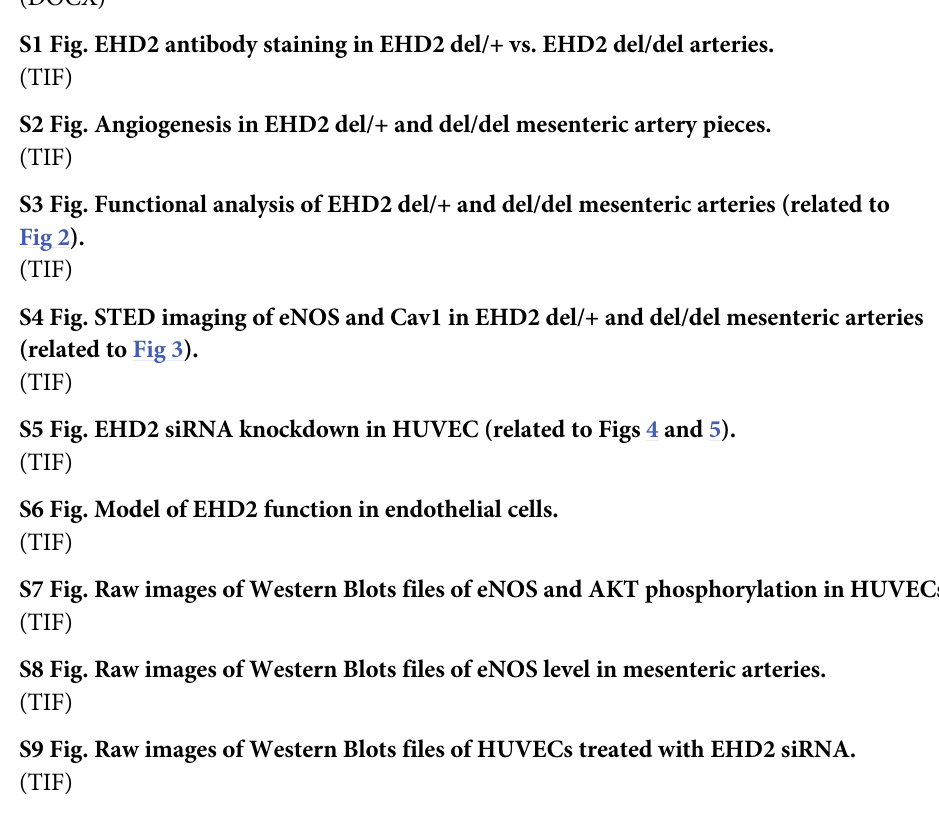
S1 Table. Echocardiography of 20 weeks old EHD2 del/+ and del/del mice before and after 2 weeks running wheel training. S1 Fig. EHD2 antibody staining in EHD2 del/+ vs. EHD2 del/del arteries. (TIF) S2 Fig. Angiogenesis in EHD2 del/+ and del/del mesenteric artery pieces. (TIF) S3 Fig. Functional analysis of EHD2 del/+ and del/del mesenteric arteries (related to Fig 2). S4 Fig. STED imaging of eNOS and Cav1 in EHD2 del/+ and del/del mesenteric arteries (related to Fig 3). S5 Fig. EHD2 siRNA knockdown in HUVEC (related to Figs 4 and 5). S6 Fig. Model of EHD2 function in endothelial cells. S7 Fig. Raw images of Western Blots files of eNOS and AKT phosphorylation in HUVECs. S8 Fig. Raw images of Western Blots files of eNOS level in mesenteric arteries. (TIF) S9 Fig. Raw images of Western Blots files of HUVECs treated with EHD2 siRNA.